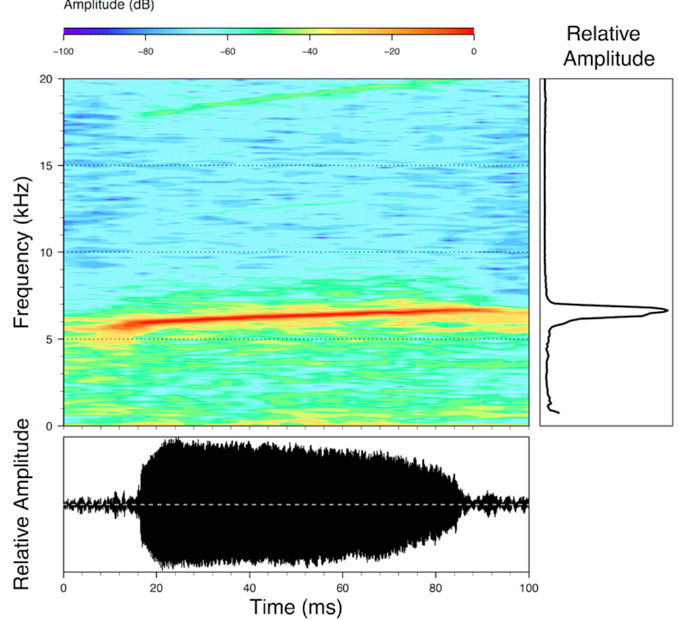
Figure 122. Call of a male (USNM 201475) tentatively assigned to Hyalinobatrachium valerioi , recorded near Santo Domingo de los Colorados, Ecuador, recorded by RWM.